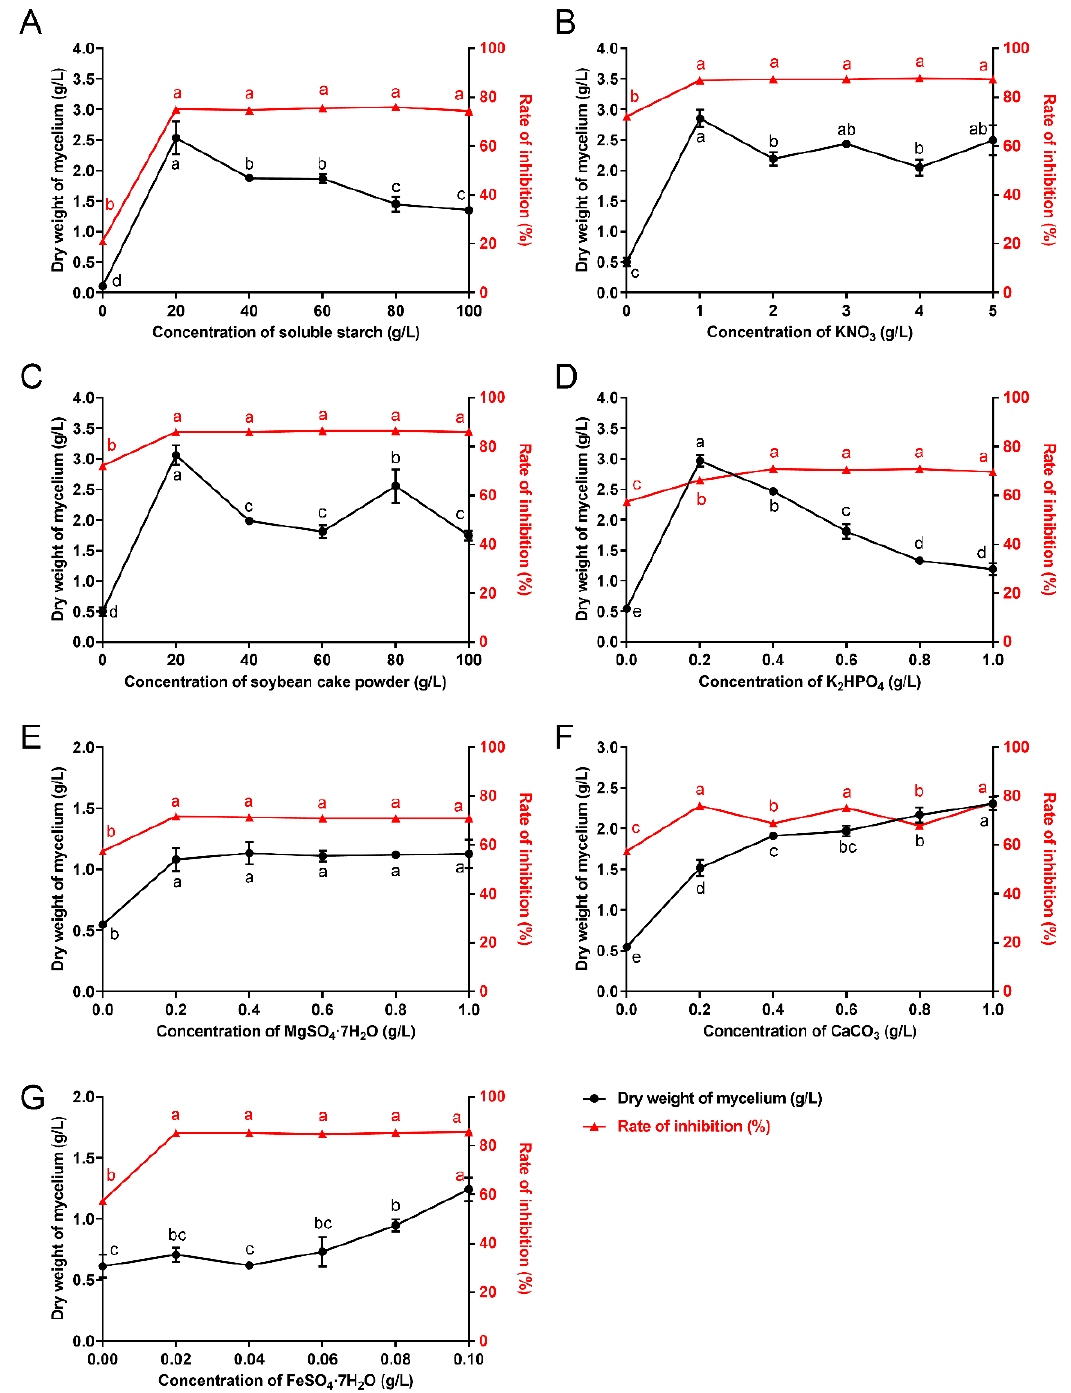
Figure 2. Effect of nutrient sources at different concentrations on the biomass yield and antifungal metabolites production of S. alfalfae XN-04. ( A ) Soluble starch. ( B ) KNO 3 . ( C ) Soybean cake powder. ( D ) K 2 HPO 4 . ( E ) MgSO 4 · 7H 2 O. ( F ) CaCO 3 . ( G ) FeSO 4 · 7H 2 O. The dry weight of mycelium was used as indication of biomass (corresponds to the left X axis), and the rate of inhibition was used as indication of antifungal metabolites production (corresponds to the right Y axis). Bars represent the SD of three replicates. Different lowercase letters indicate a significant difference at p < 0.05 level by Duncan’ s new multiple range test.